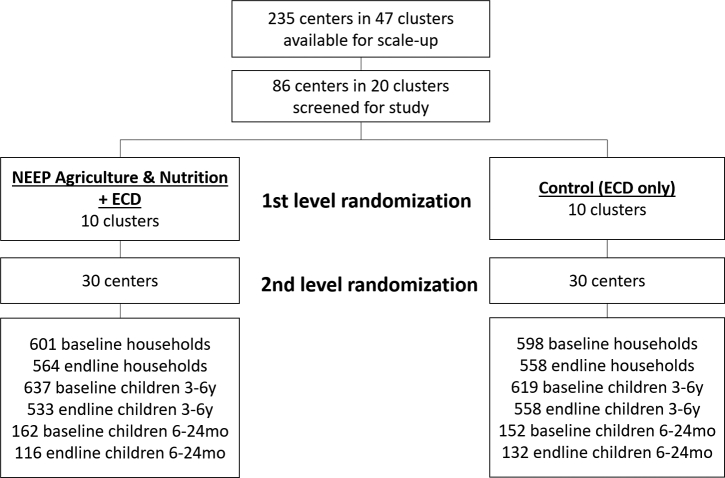
Schematic view of the randomization process and trial profile. ECD, Early Childhood Development; NEEP, Nutrition Embedded Evaluation Program.